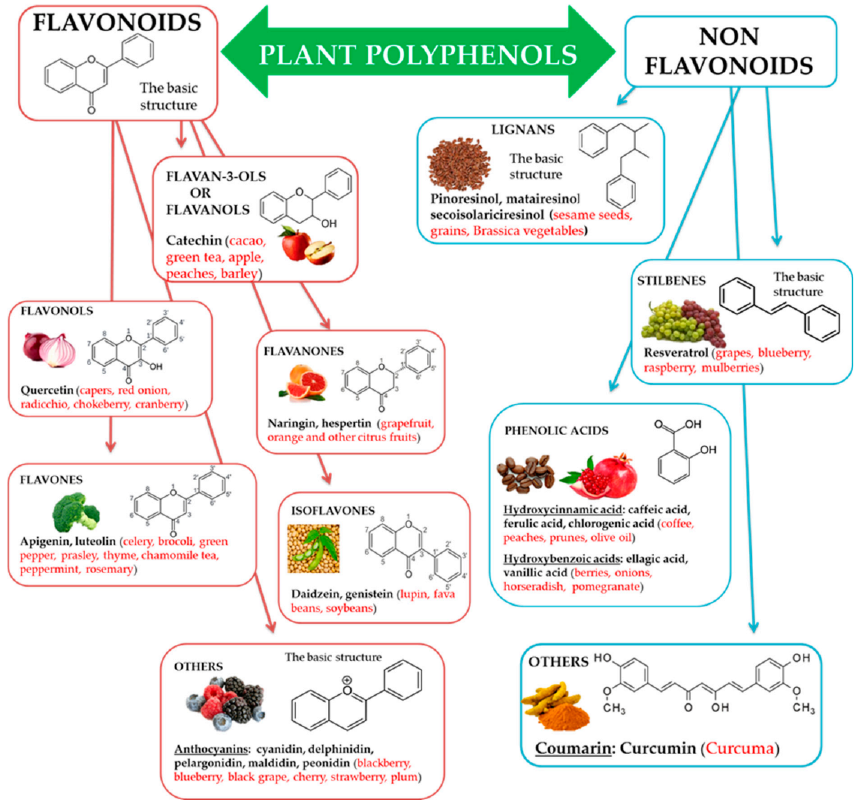
Figure 1. Polyphenols, subclasses, basic chemical structures, and representative polyphenolic-food sources (in